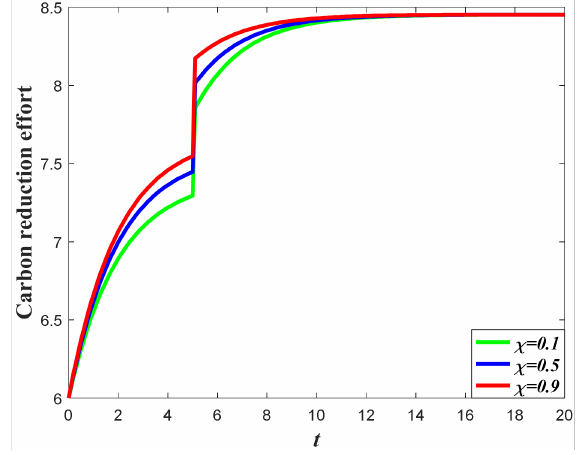
Figure 7. Impacts of χ on carbon reduction effort.